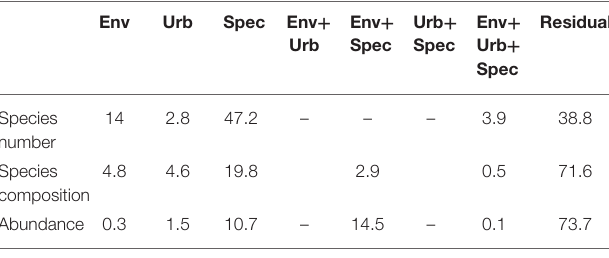
TABLE 3 | Results of the variance partitioning analyses (% explained and residual variance) for species number, species composition, and